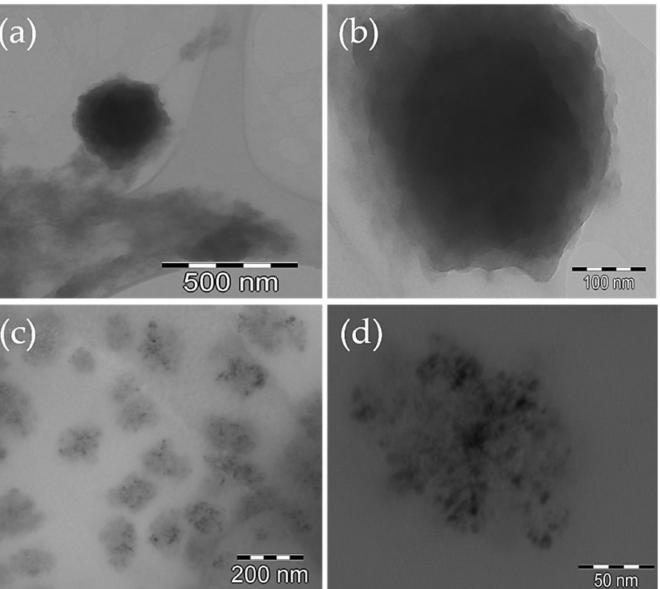
Figure 2. TEM pictures of CS/HY NPs before ( a , b ) and after ( c , d ) lyophilization at different magnifications.